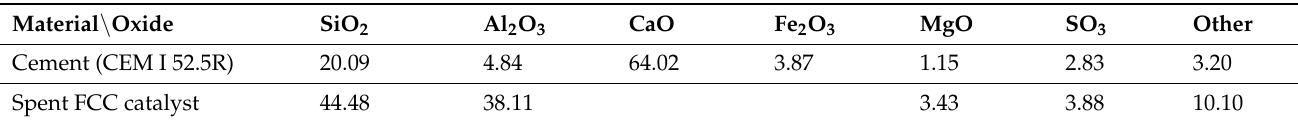
Figure 1. SEM images of microstructure of the materials: ( a ) cement; ( b ) spent FCC catalyst. Table 1. Chemical composition of the materials, wt.%.